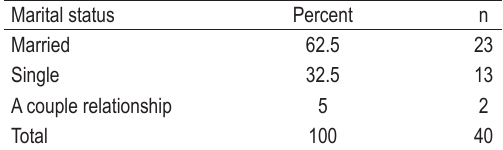
TABLE 10. The use of hearing aids